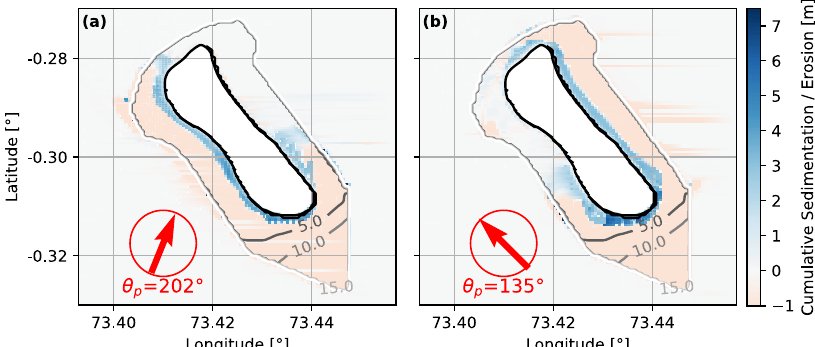
Fig. 6 Modeled sediment transport. Sediment relocation calculated with Delft3D (D3D) for constant waves of one month with signi fi cant wave height H = 2.3 m, peak period T = 17 s approaching from a θ = 202 ∘ and b θ = 135 ∘ . The offshore depth is truncated to 100 m. The idealized reef has a depth of s p p p 5 m to 17.5 m. Gray contour lines mark the water depth on the reef between 5 m to 15 m in 5 m increments. The erodible sediment layer is 1 m throughout the domain. Sediment accumulation is blue, while erosion is red. The maximum erodible depth is equal to the erodible sediment layer thickness. Map data is idealized, based on